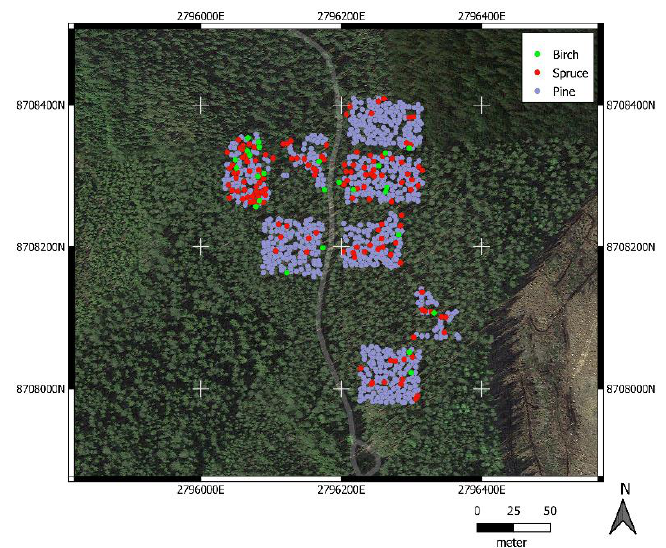
Figure 2. Location and distribution of trees in the third region. Each class is individually colored.